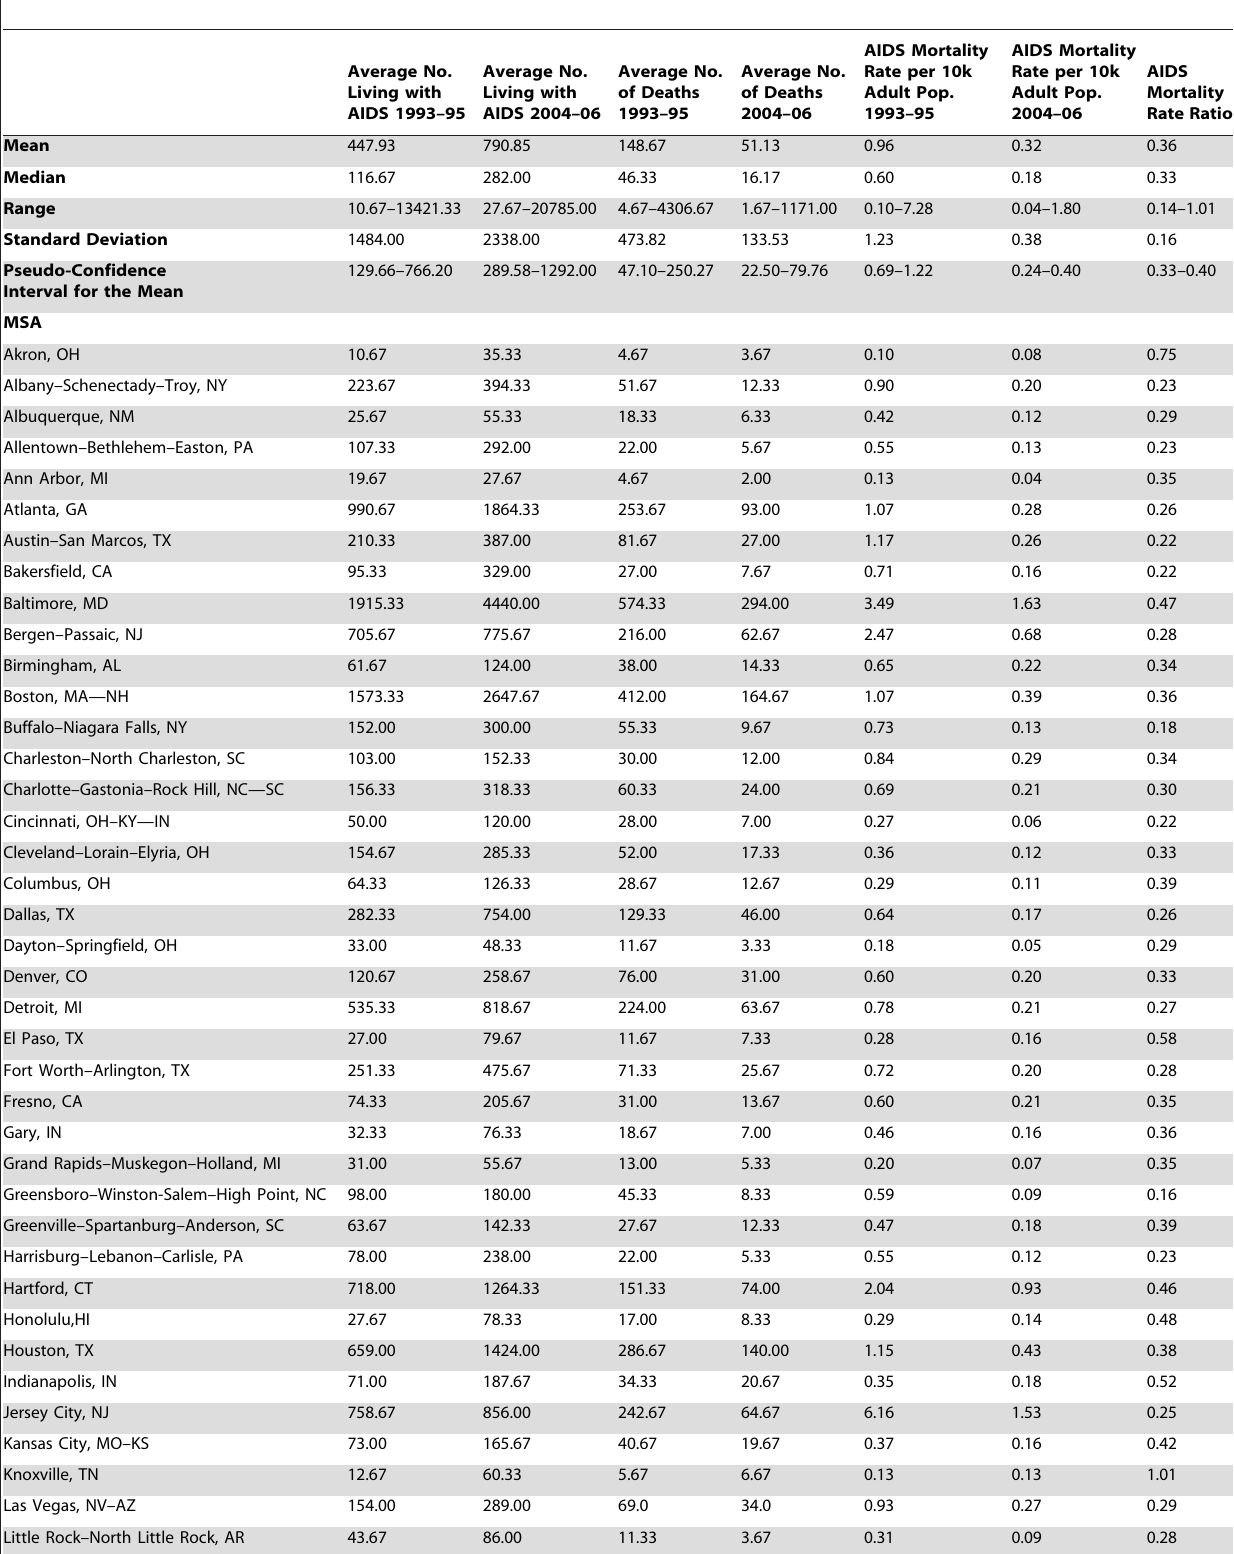
Table 1. Average number IDU living with AIDS, number of AIDS deaths, and AIDS mortality rates of IDUs living with AIDS per (HAART era), and the AIDS mortality rate ratio between late and early